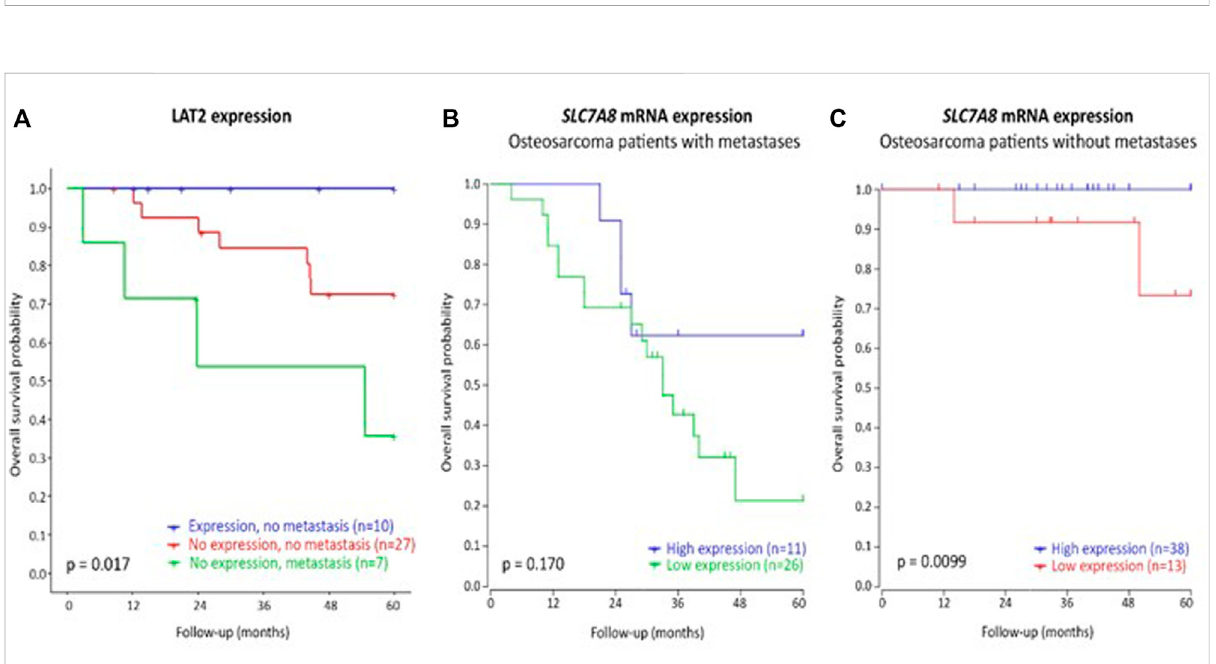
FIGURE 4 Overall survival of osteosarcoma patients according to or LAT2 protein expression (A) , strati fi ed for the presence of metastasis, or SLC7A8 mRNA expression (B,C) . Protein expression was determined by immunohistochemistry in the discovery cohort of this study and no patients with LAT2 expression and metastases at diagnosis were identi fi ed. mRNA expression was analyzed in an independent patient cohort (Kuijjer et al.,